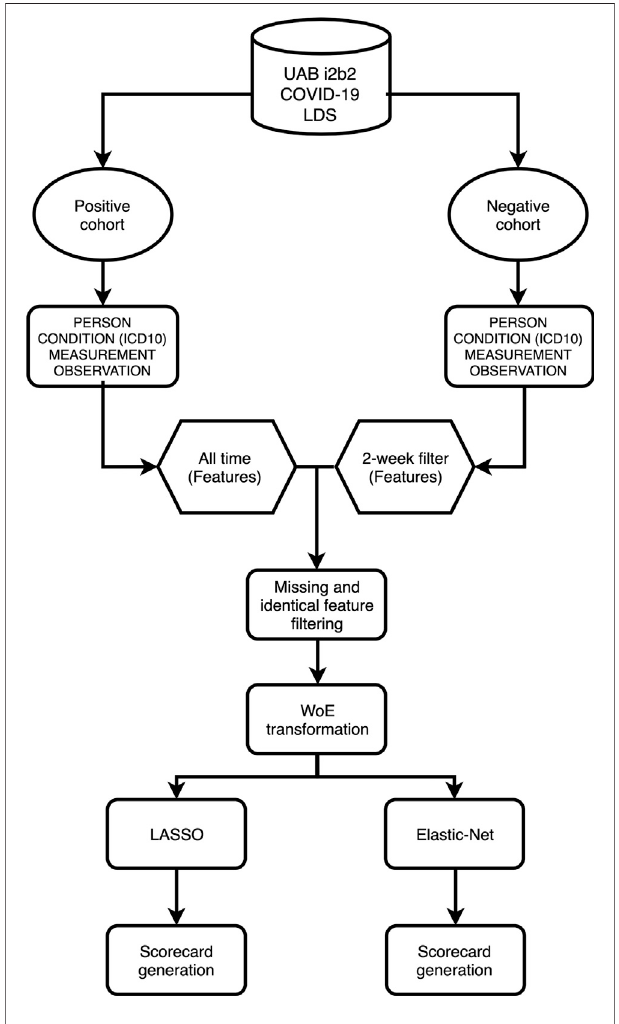
FIGURE 1 | Overview of